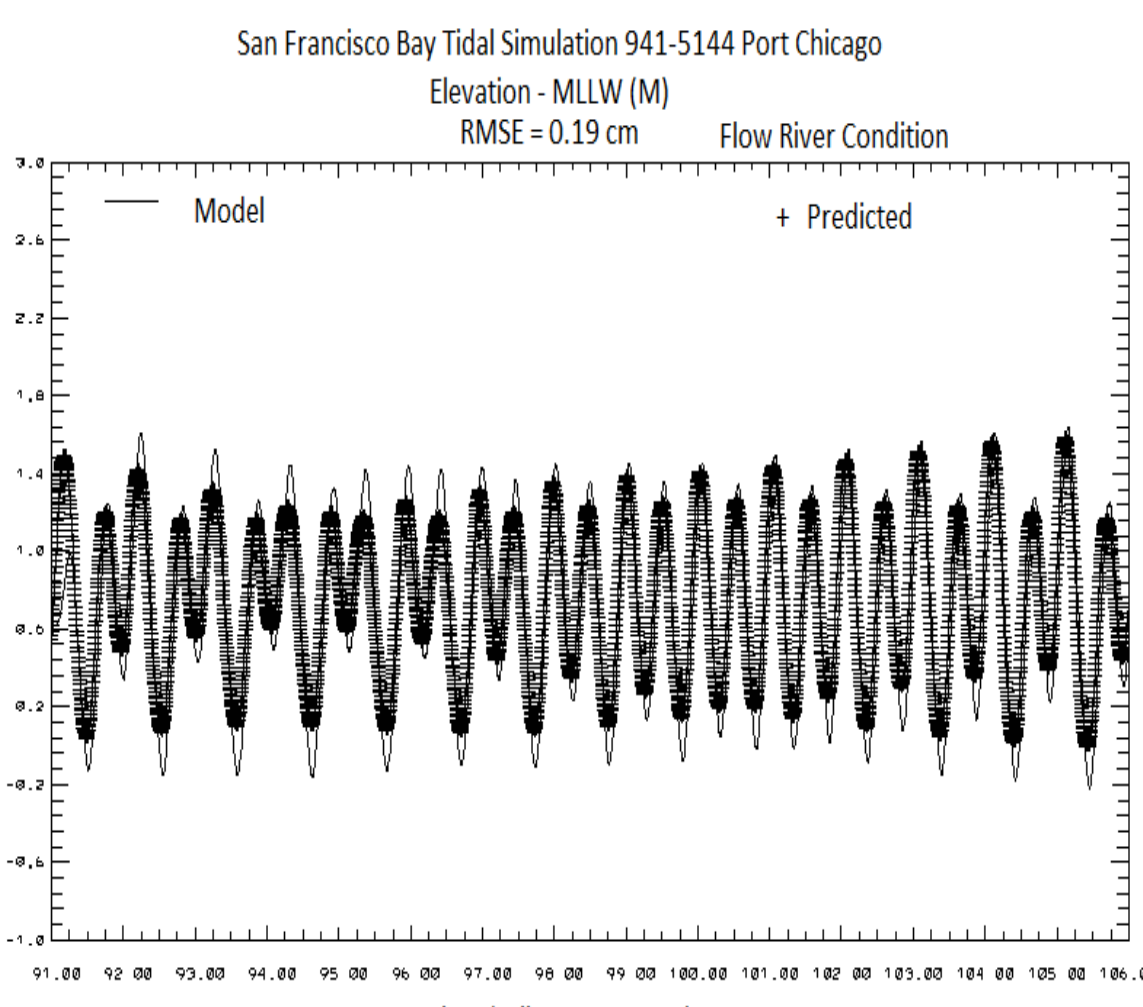
Figure 4. Comparison of modeled versus predicted water level at Port Chicago with flow boundary condition over the period 1–15 April